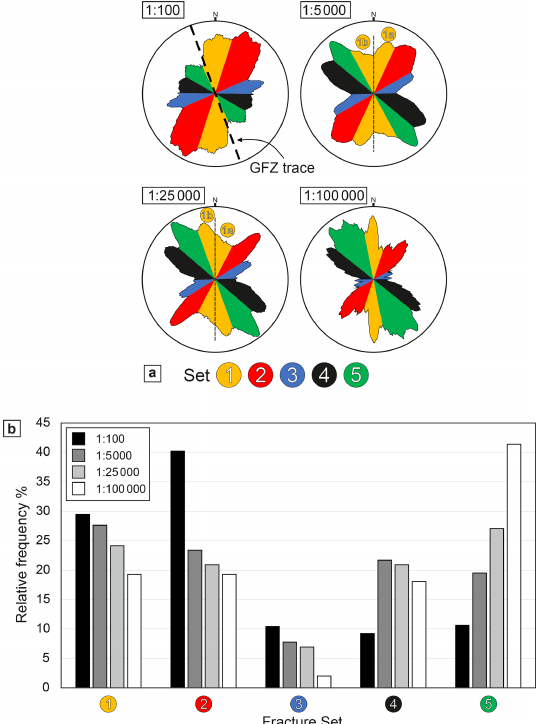
Figure 5. Rose diagrams (a) and histograms of the relative frequen- cies (b) of the identified orientation sets at different scales of obser-